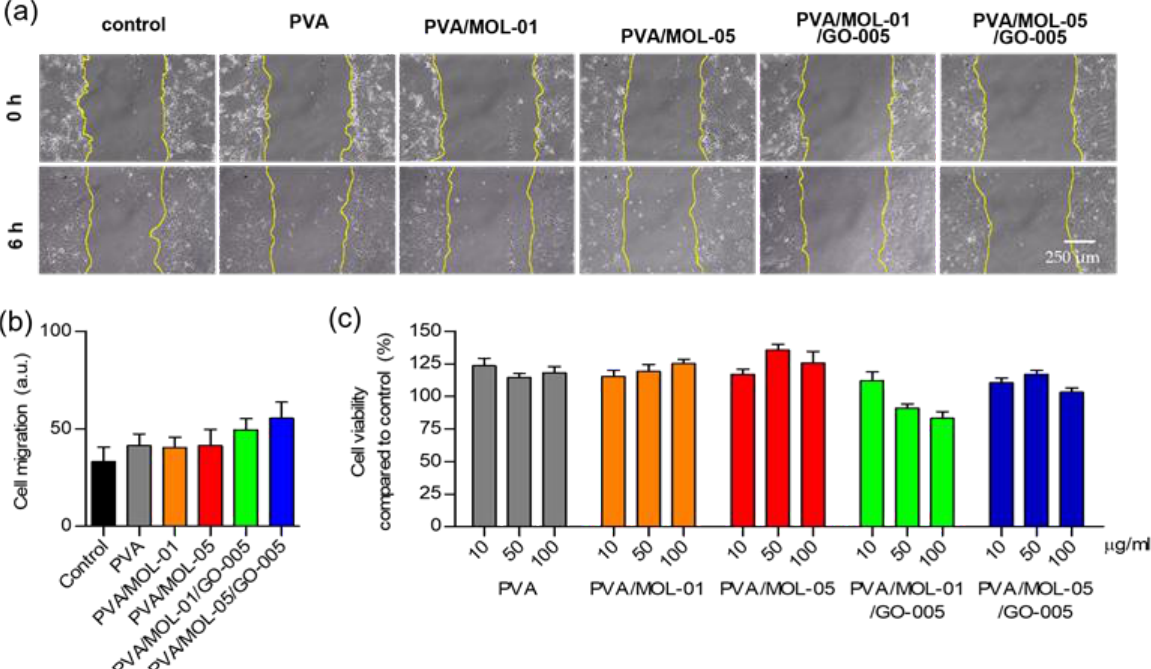
Figure 8. In vitro evaluation of cell migration and cytotoxicity using the mouse fibroblast 3T3L1 cells line. ( a ) Representative microscopic image and ( b ) quantitative analysis of the cell migration assay measured by the gap of the scratch area after a 6 h incubation at 50 µg/mL concentration. ( c )